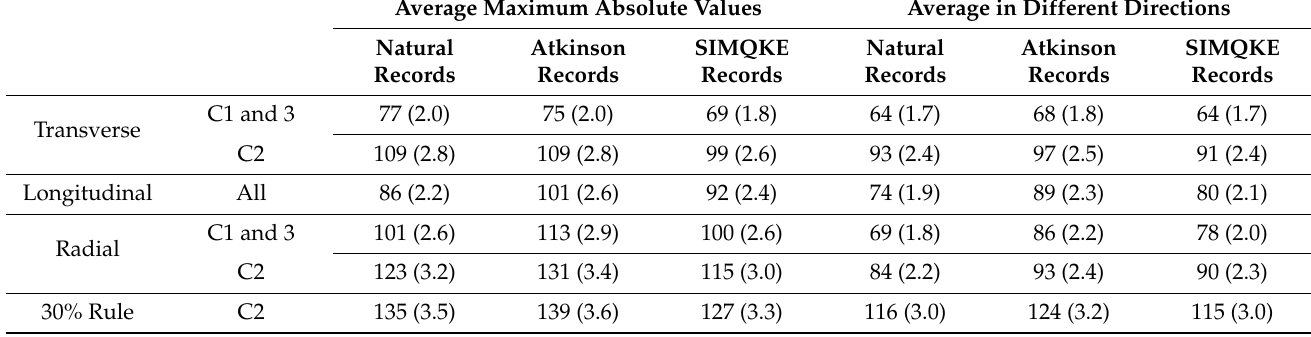
Table 2. Summary of the mean displacements (mm) of columns using 3D analysis for the regular bridge with mean ductility demands given in brackets.